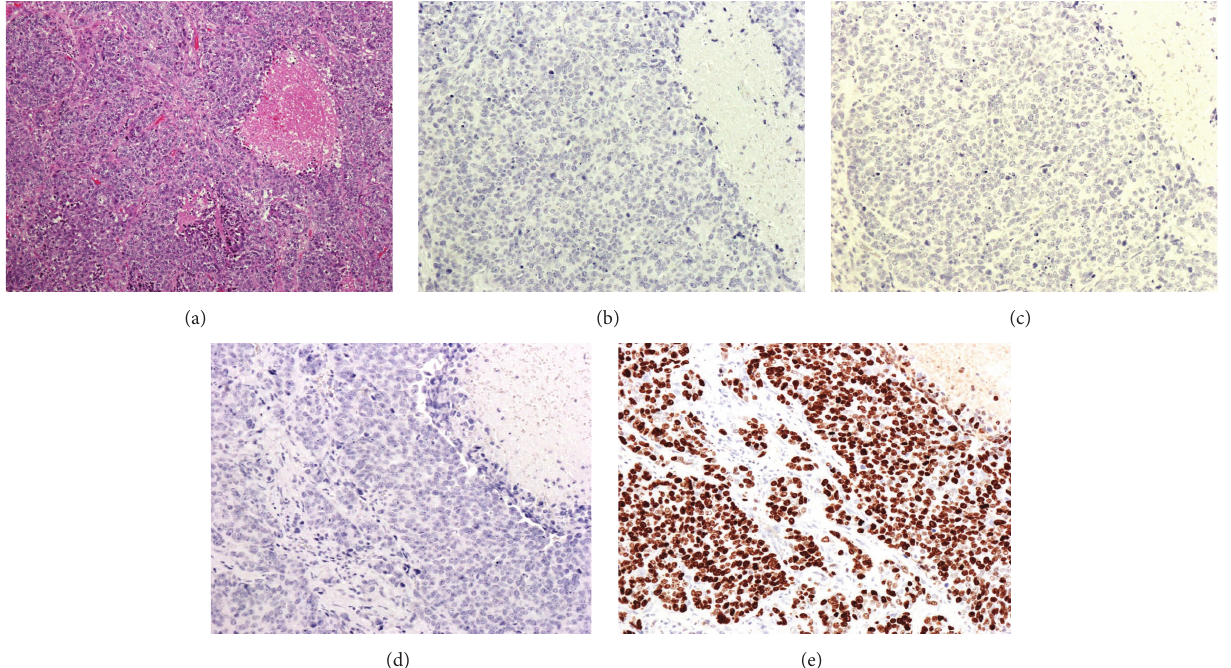
Figure 3: Histological examination indicates a diagnosis of invasive ductal carcinoma ((a) hematoxylin-eosin [HE] staining). Immunohis- tochemical examination indicates that the tumor was negative for human epidermal growth factor receptor 2 (HER-2) (b), estrogen receptor (ER) (c), and progesterone receptor (PR) (d). Moreover, the Ki-67 expression index is 80% (e).